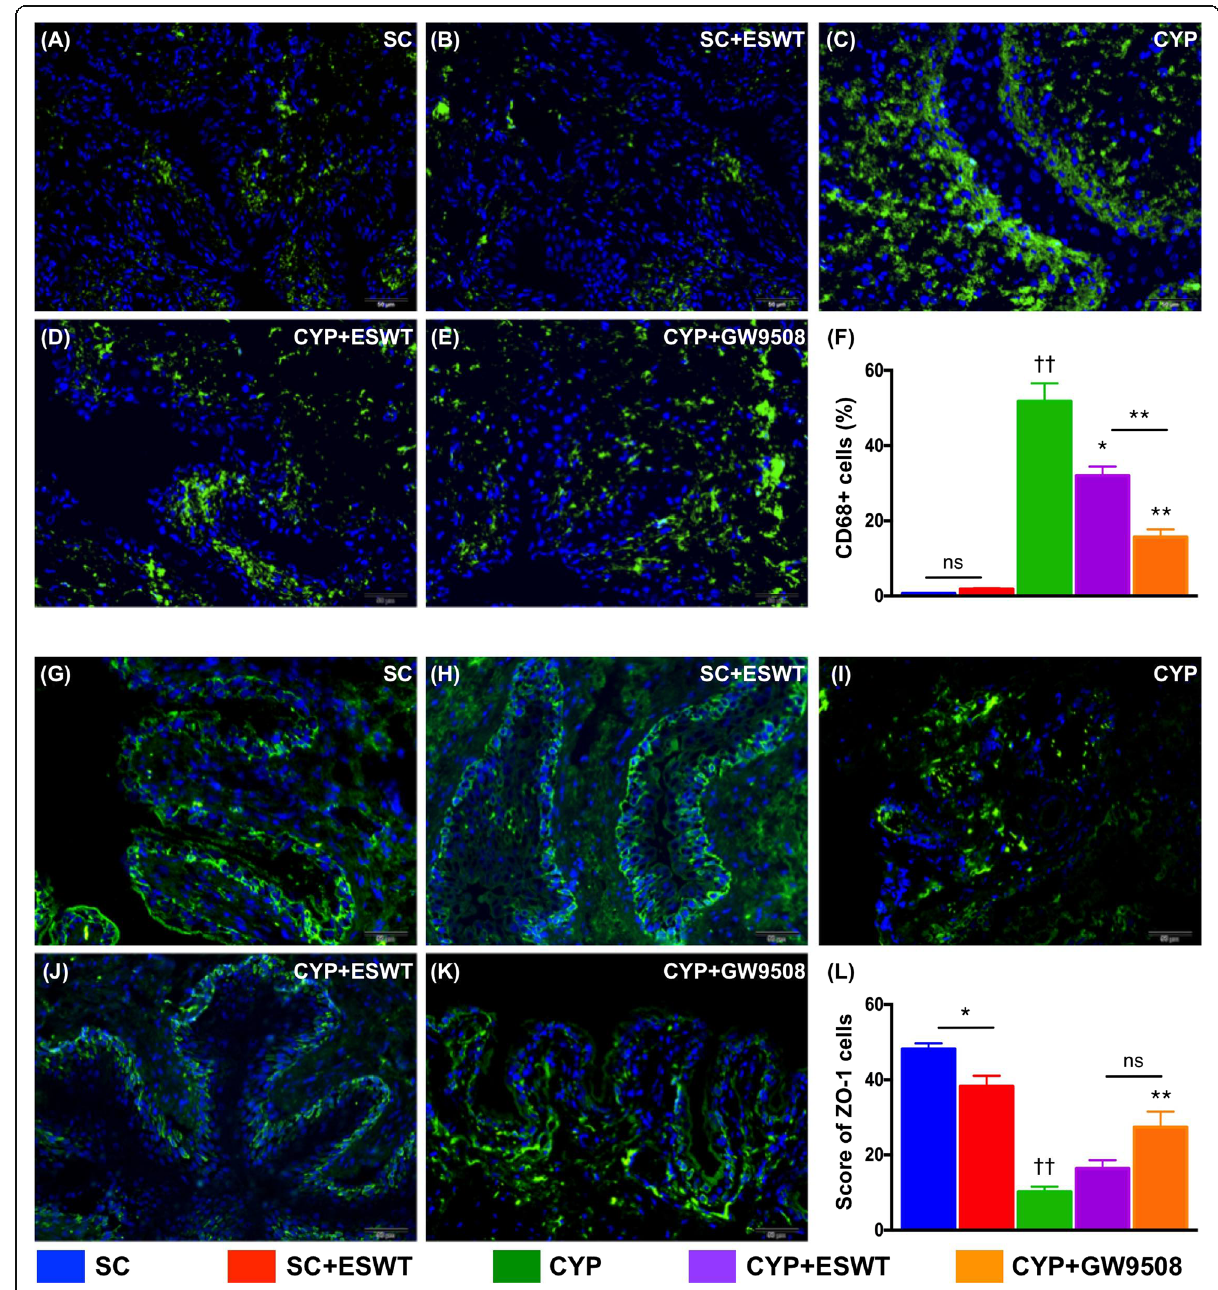
Fig. 8 Inflammatory cells infiltration and urothelial tight junction integrity of urinary bladder in rats following cyclophosphamide (CYP) stimulation with and without GPR120 agonist / extracorporeal shock wave treatment (ESWT). Immunofluorescent (IF) staining of bladder sections with CD68 antibody showing normal urothelium in sham controls with ( a ) and without ( b ) ESWT. Inflammation noted in rats following CYP treatment ( c ). Significant attenuation of inflammatory cell infiltration after ESWT ( d ) and GPR120 agonist (i.e., GW9508) ( e ) treatment. f Summary of differences in numbers of CD68+ cells in the five groups of animals ( n = 6 per group). IF staining of ZO-1 showing normal urothelial integrity in sham controls with ( g ) and without ( h ) ESWT. Impaired urothelial integrity noted in rats following CYP treatment ( i ). Significant protection of urothelial integrity after ESWT ( j ) and GPR120 agonist (i.e., GW9508) ( k ) treatment. f Summary of differences in numbers of ZO-1+ cells in the five groups of animals ( n = 6 per group). Values expressed as the mean ± SEM. * p < 0.05, ** p < 0.01 vs. CYP; †† p < 0.01 vs. controls; ns, non-significance. Significance of differences determined by one-way ANOVA followed by Bonferroni ’ s post-hoc comparisons tests. Scale bars in right lower corner represent 100 μ m. SC = sham control; CYP = cyclophosphamide; ESWT = extracorporeal shock wave treatment; GW9508= GPR120